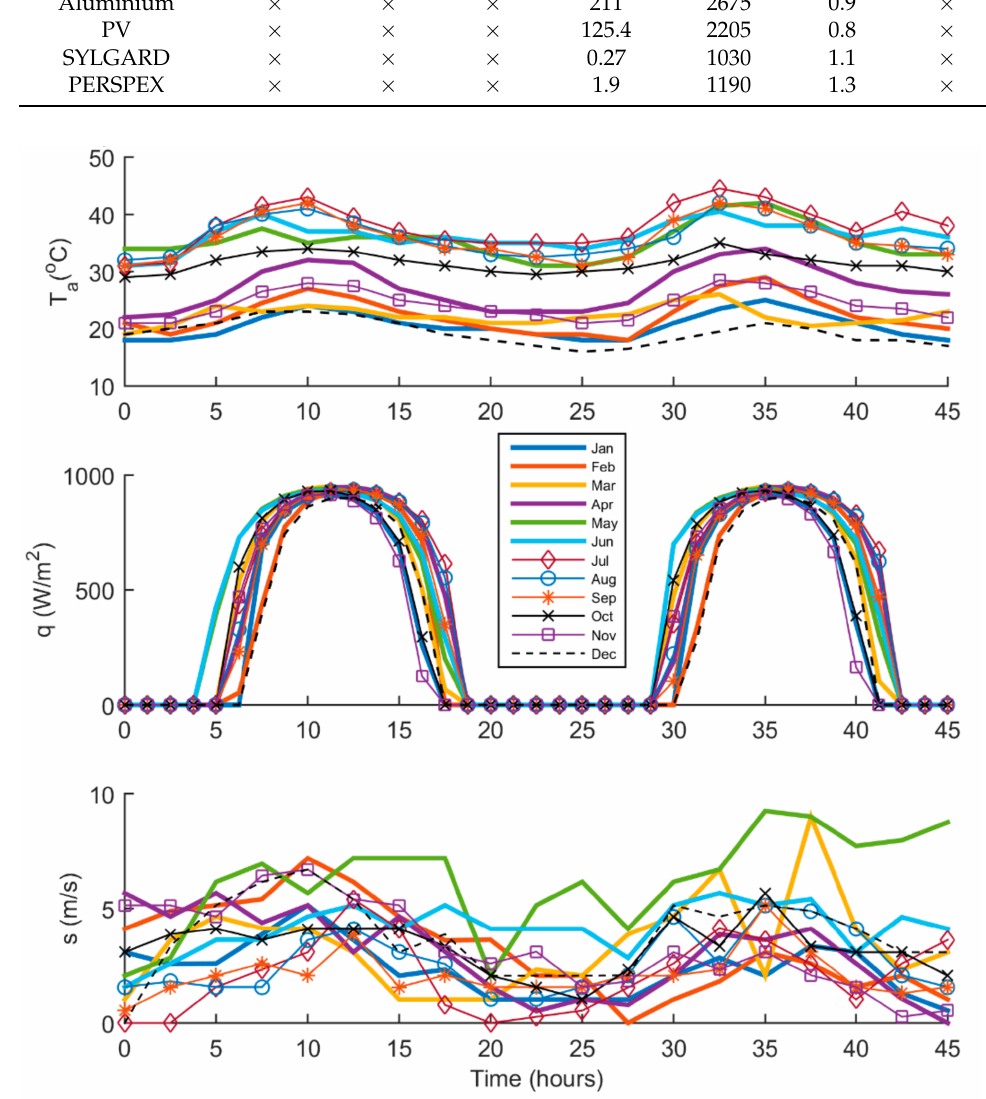
Figure 2. Irradiance, wind speed and ambient temperature for selected days of the